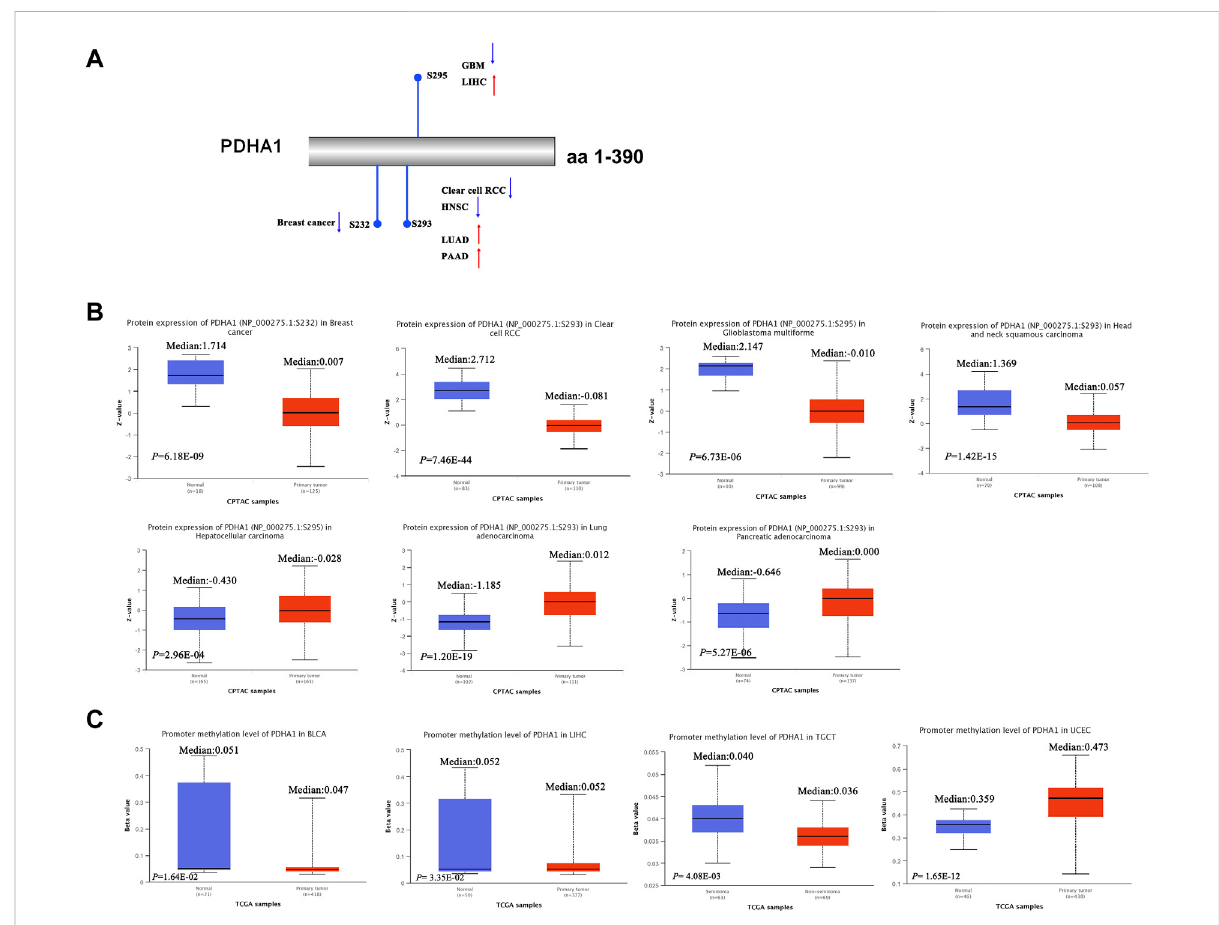
FIGURE 4 Protein phosphorylation and DNA methylation of PDHA1 in pan-cancer. (A,B) CPTAC indicated the phosphorylation levels of PDHA1 at S232, S293, and S295. (C) DNA methylation of PDHA1 between normal and primary tumor tissues was performed by the UALCAN